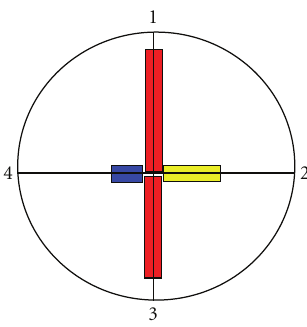
Figure 11: Plausible configuration for 0 . 23 < τ + < 0 . 35. Rectangles represent schematically the respective lengths of the sheet cavities on the four blades (1.2 N ref , Q n ).